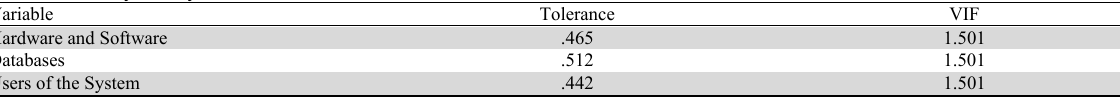
Multicollinearity Analysis